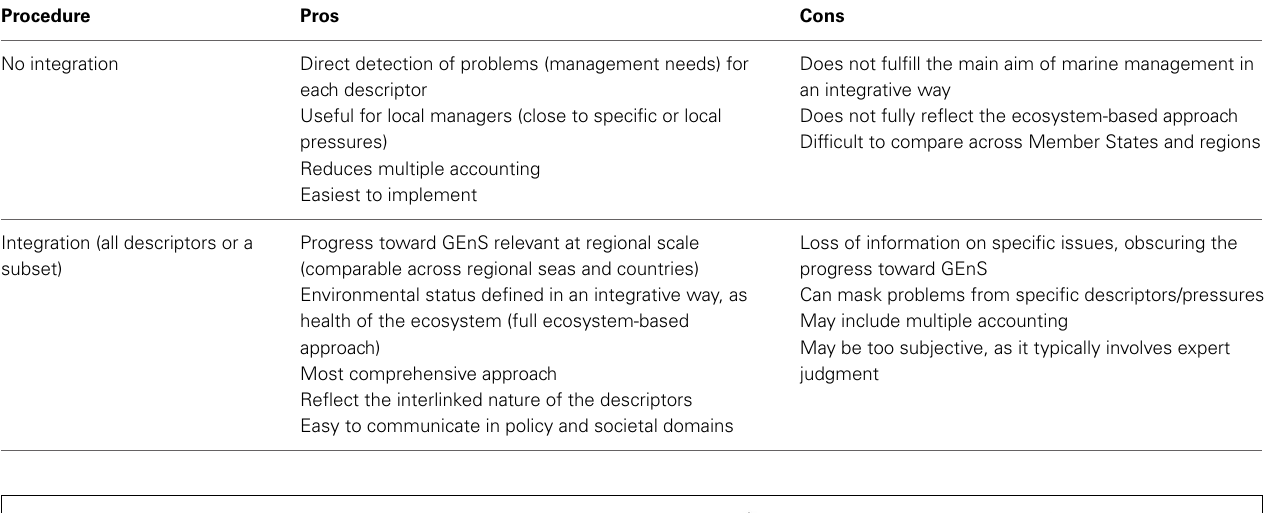
Table 6 | Pros and cons of the decision of integrating the information across descriptors.